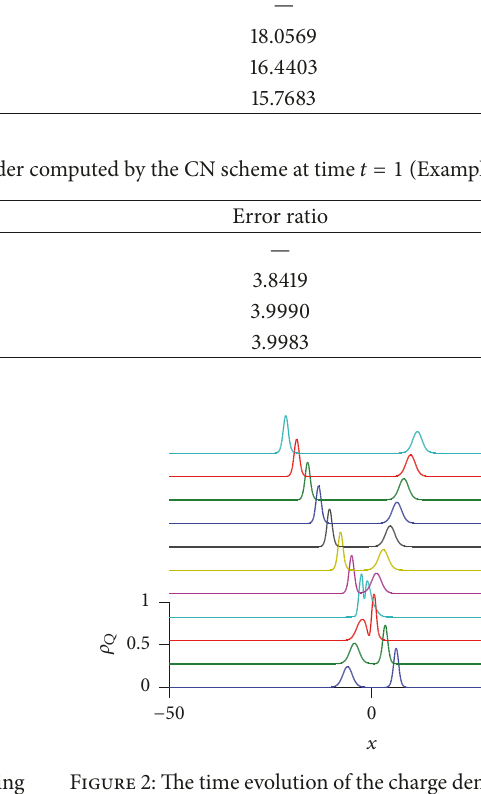
Table 3: The error, error ratio, and accuracy order computed by the CT-IIF4 scheme at time 푡 = 1 (Example 1). Mesh size 푒 ∞ Error ratio Order ℎ = 0.8, 휏 = 0.04